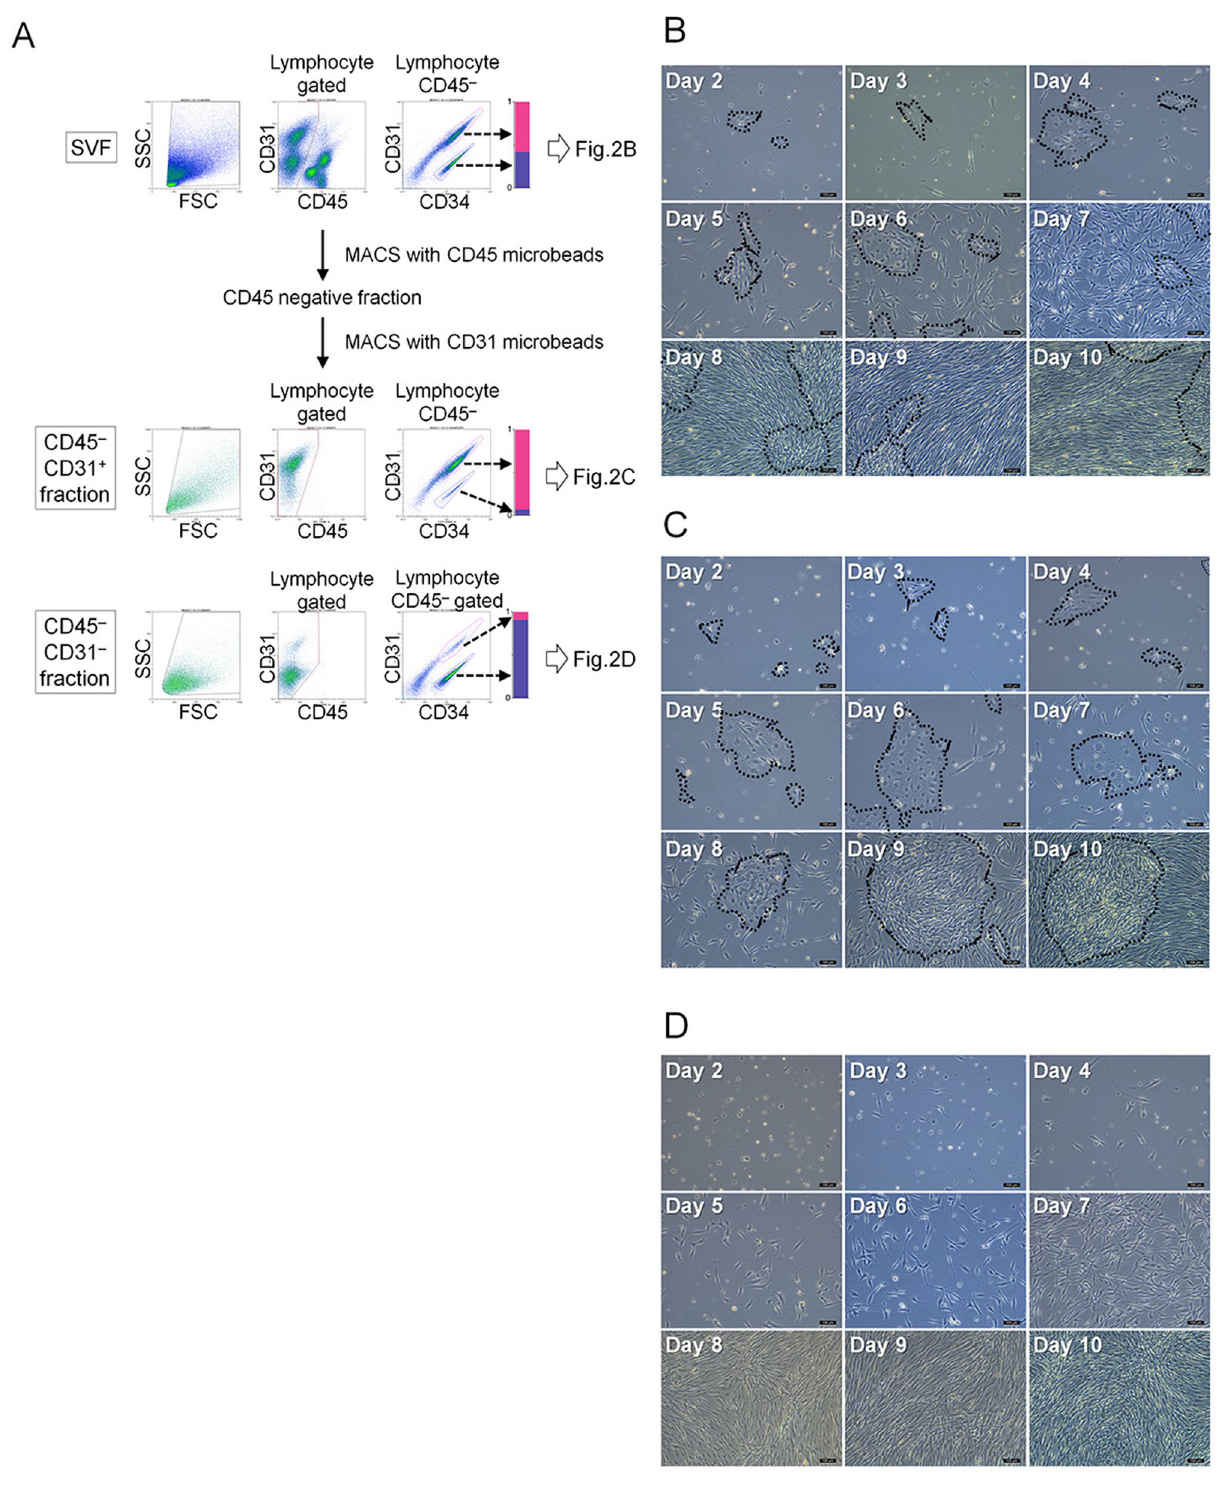
Figure 2. MACS separation and culture of the SVF. ( A ) The freshly isolated, hemolyzed SVF was separated into CD45 − CD31 + (AEPC-rich) and CD45 − CD31 − fractions (ASC-rich) in the first MACS separation. During this flow cytometric analysis, lymphocyte gating events in the SSC versus SFC plot were set to 100%. CD45 − CD34 + CD31 + (magenta ROI) was defined as the AEPC population. CD45 − CD34 + CD31 − (violet ROI) was defined as the ASC population. Bar charts display the ratio between the CD45 − CD31 + CD34 + and CD45 − CD31 + CD34 − populations in the SVF (upper panels), CD45 − CD31 + , (middle panels), and CD45 − CD31 − fractions (lower panels), which were 0.54 to 0.46 ± 0.075 (n = 9, 9 donors, mean ± SD), 0.95 to 0.05 ± 0.03 (n = 5, 5 donors, mean ± SD), and 0.18 to 0.82 ± 0.08 (n = 5, 5 donors, mean ± SD), respectively. Cultivation of the ( B ) freshly isolated SVF, ( C ) first MACS-separated CD45 − CD31 + fraction (AEPC-rich), and ( D ) first MACS-separated CD45 − CD31 − fraction (ASC-rich). The morphologies of all the populations were photographed daily from days 2–10 using a phase-contrast microscope (Leica DM IL LED with a camera MC170HD; 100× magnification). Bars represent 100 µm. All the cell populations were seeded at 1 × 10 4 nucleated cells/0.2 mL of EGM-2 media/ cm 2 . Dotted circles indicate AEPC colonies. The experiment was performed twice, independently from 2